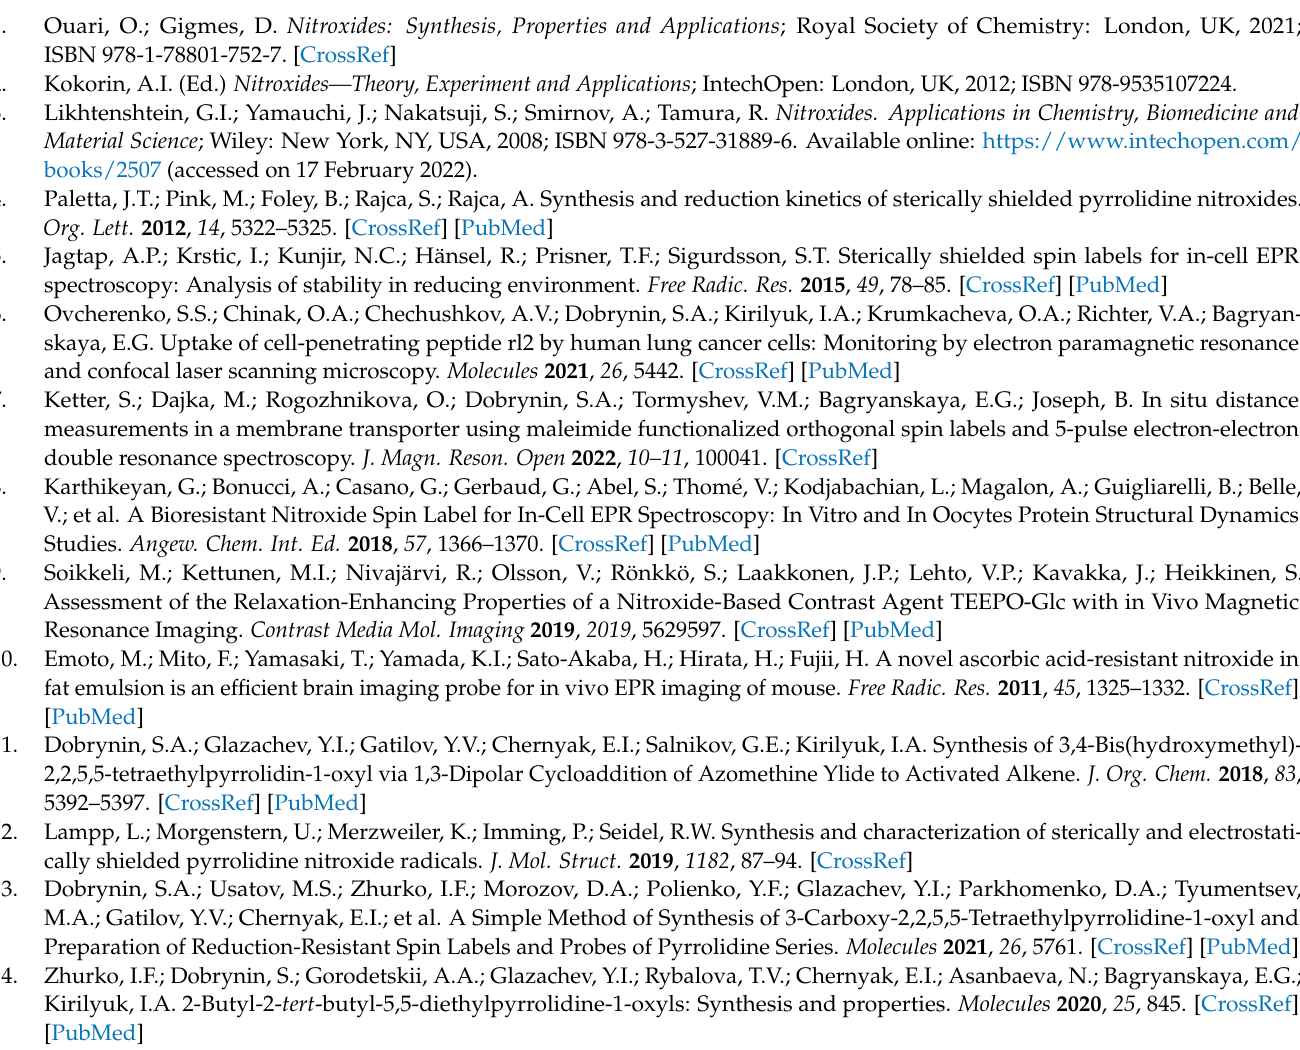
Figure A2. Assignment of signals of 13 C-NMR (black) and 1 H NMR (blue) for 10a_ red . Slashed red lines show through-space interactions in 1 H, 1 H–NOESY spectrum.